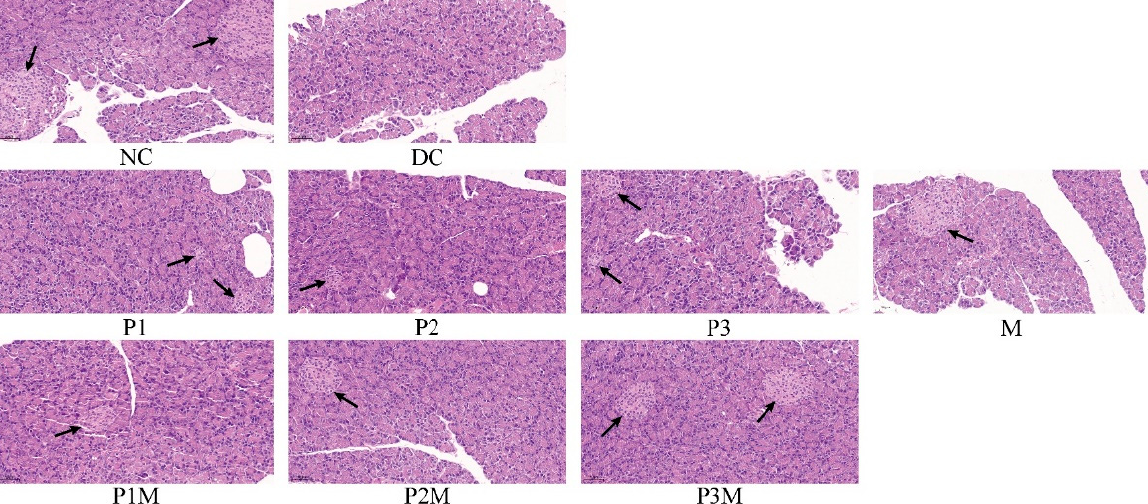
Figure 3. The histology of the pancreas. The black arrows show the locations of islets in the pancreas. The groups are represented as follows: NC, normal control; DC, diabetic control; P1, puerarin (80 mg/kg); P2, puerarin (120 mg/kg); P3, puerarin (160 mg/kg); M, metformin (100 mg/kg); P1M, puerarin (80 mg/kg) + metformin (100 mg/kg); P2M, puerarin (120 mg/kg) + metformin (100 mg/kg); P3M, puerarin (160 mg/kg) + metformin (100